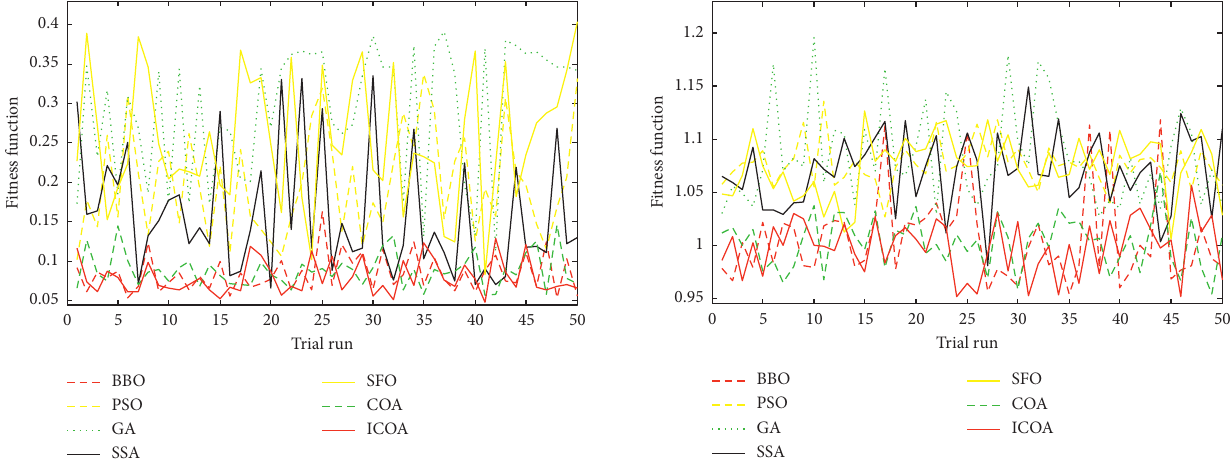
Figure 12: The fitness values of seven methods in 50 trial times for the third